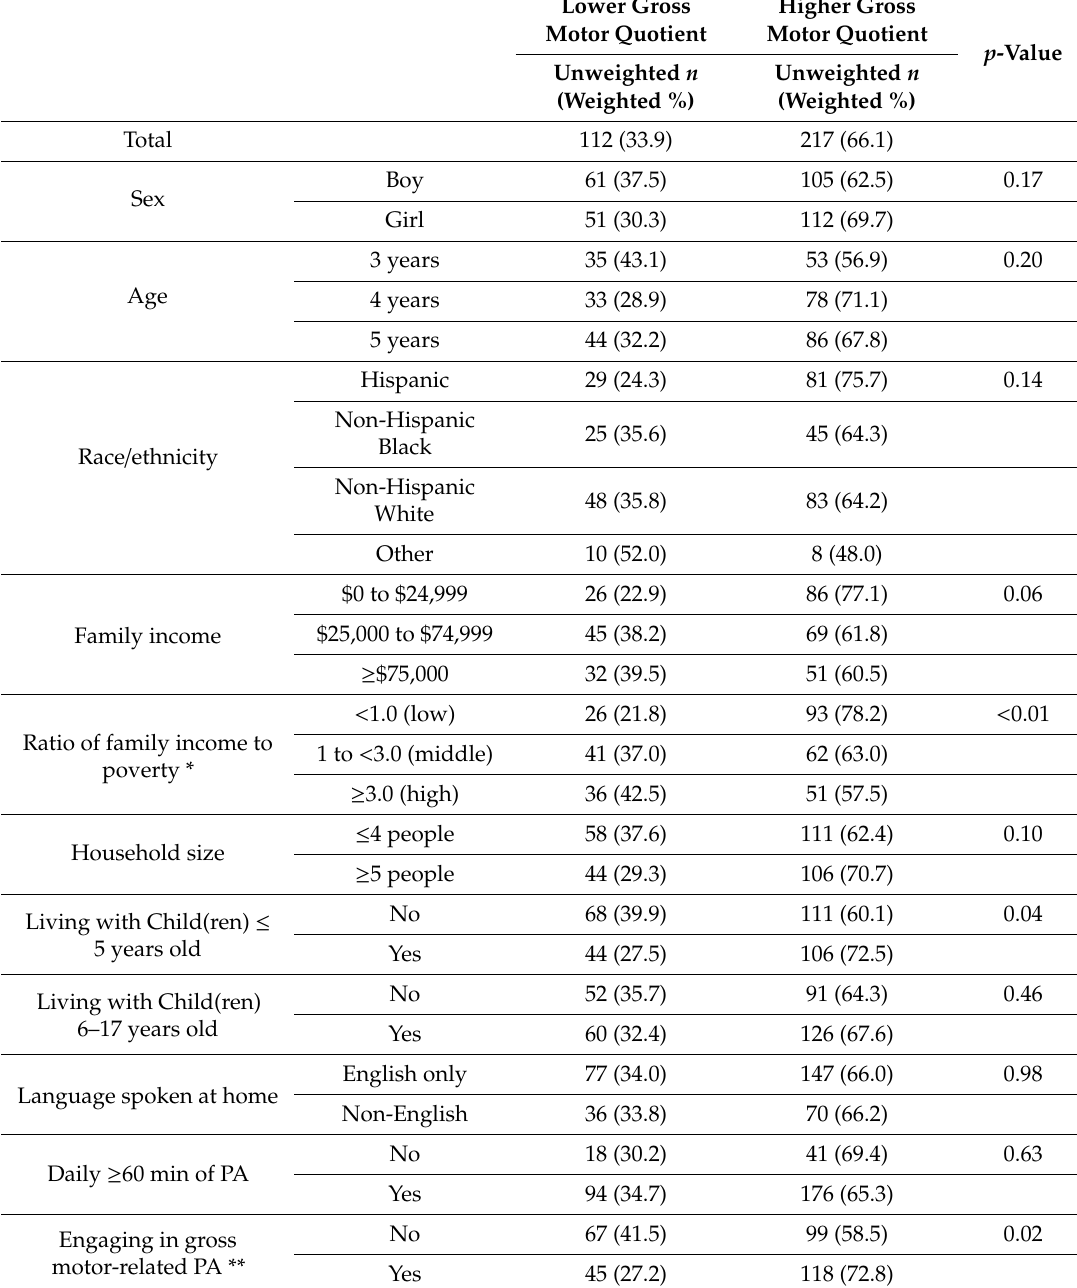
Table 2. Bivariate analyses between participant characteristics and gross motor skill